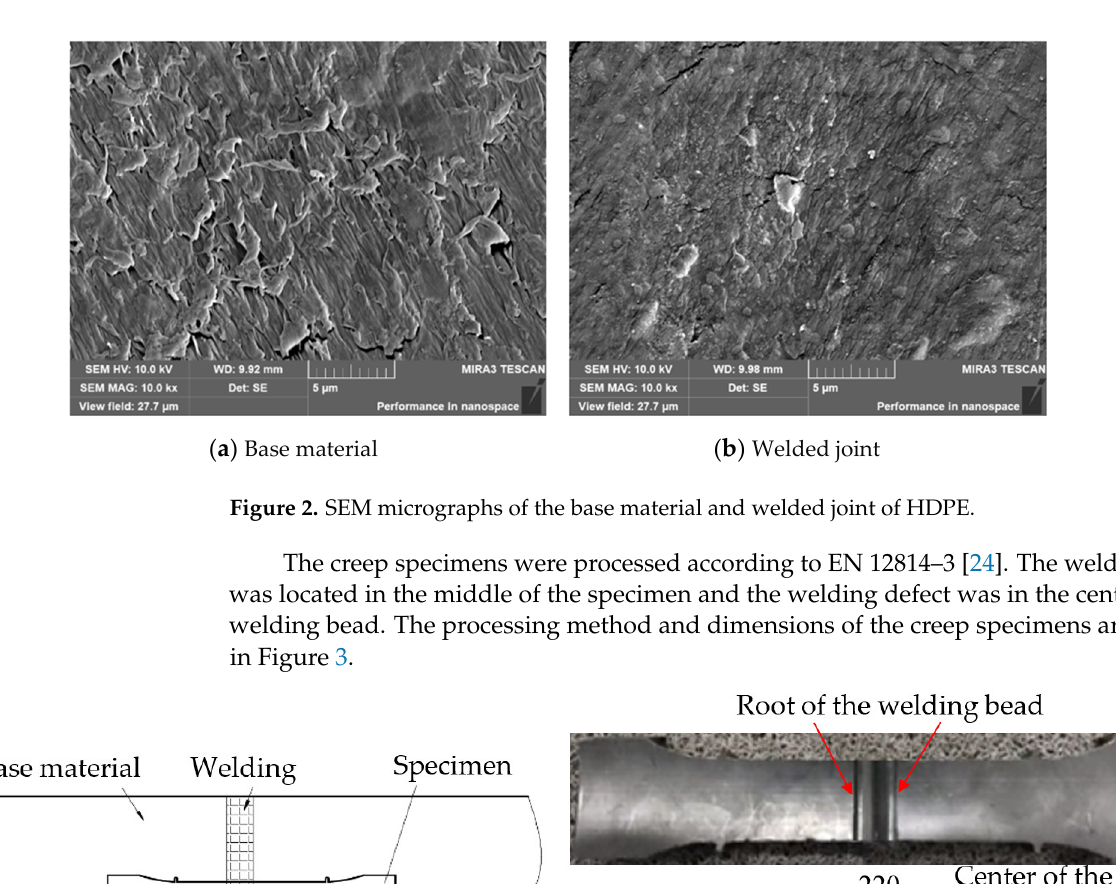
Figure 1. Process of inserting defects into the butt fusion joint of HDPE pipes.